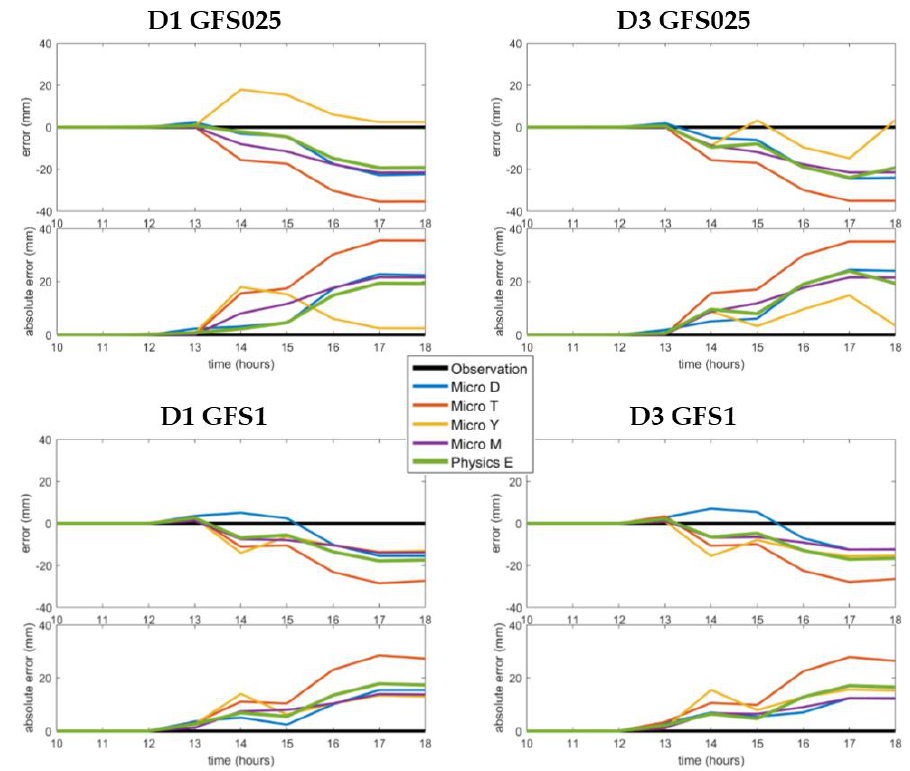
Figure 7. Hourly error (mm, upper panels) and absolute error (mm, lower panels) between 10:00 and 18:00 UTC at LEMD station. Each deterministic model configuration is shown with the four microphysics schemes, the physics ensemble for each configuration and observed